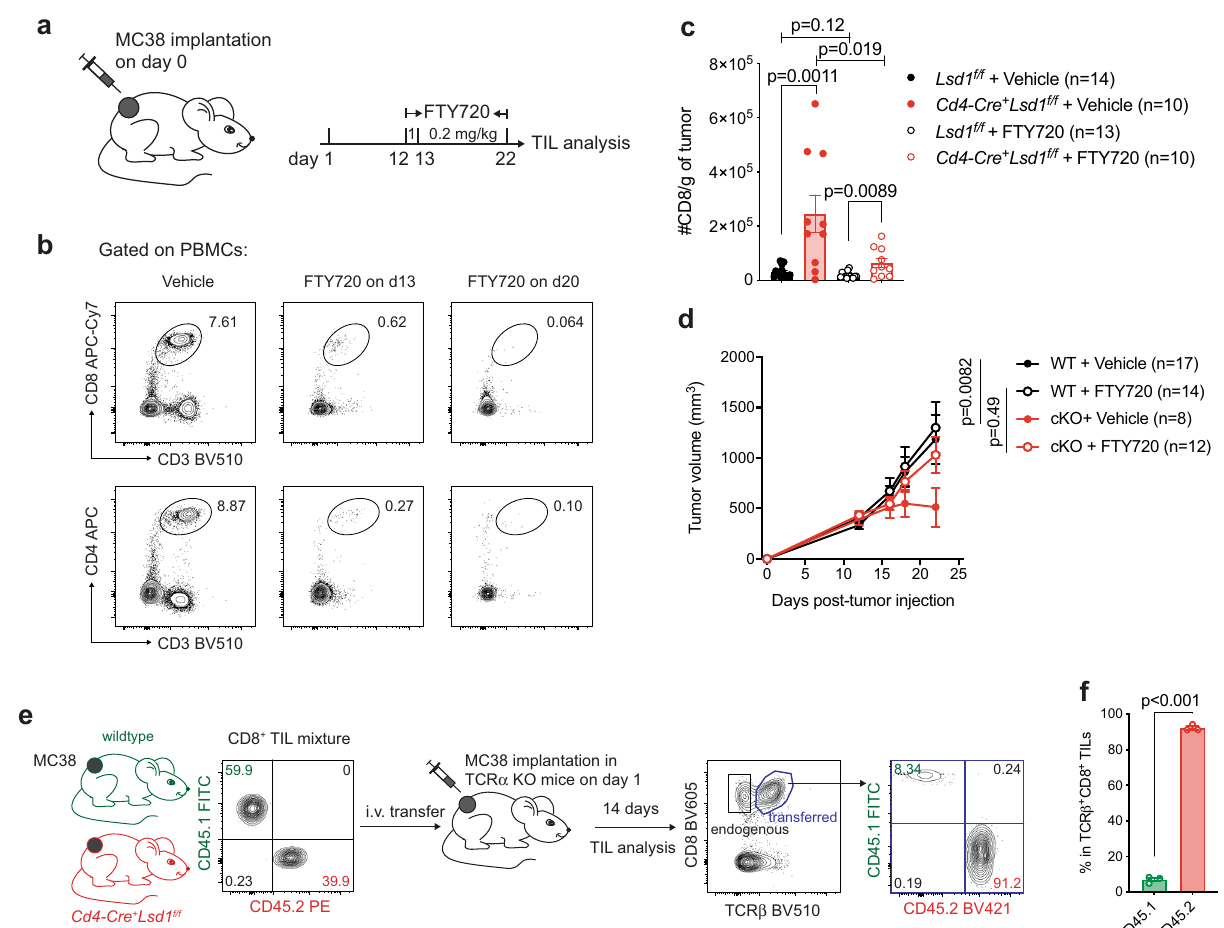
Fig. 3 LSD1 loss promotes intratumoral CD8 + T cell persistence. a Experimental design of administering FTY720 to block T cell egress. b Representative fl ow plots showing frequencies of CD4 + and CD8 + T cells in PBMCs of mice receiving FTY720 or vehicle. c Cell numbers of CD8 + TILs on day 22. d Tumor growth curves of WT and Cd4-Cre + Lsd1 f/f (cKO) mice implanted with MC38 tumors and treated with FTY720 or vehicle. e Experimental design of CD8 + TILs co-transfer and assessment of intratumoral persistence. f Frequencies of CD45.1 + wildtype and CD45.2 + LSD1-de fi cient cells among transferred TCR β + CD8 + TILs ( n = 3 per group). Data are pooled from two experiments and presented as mean ± SEM ( c , d , f ). Sample sizes are as indicated. Statistical signi fi cance was determined by two-sided unpaired t test ( c , f ) or two-way ANOVA ( d ). Source data are provided as a Source data fi